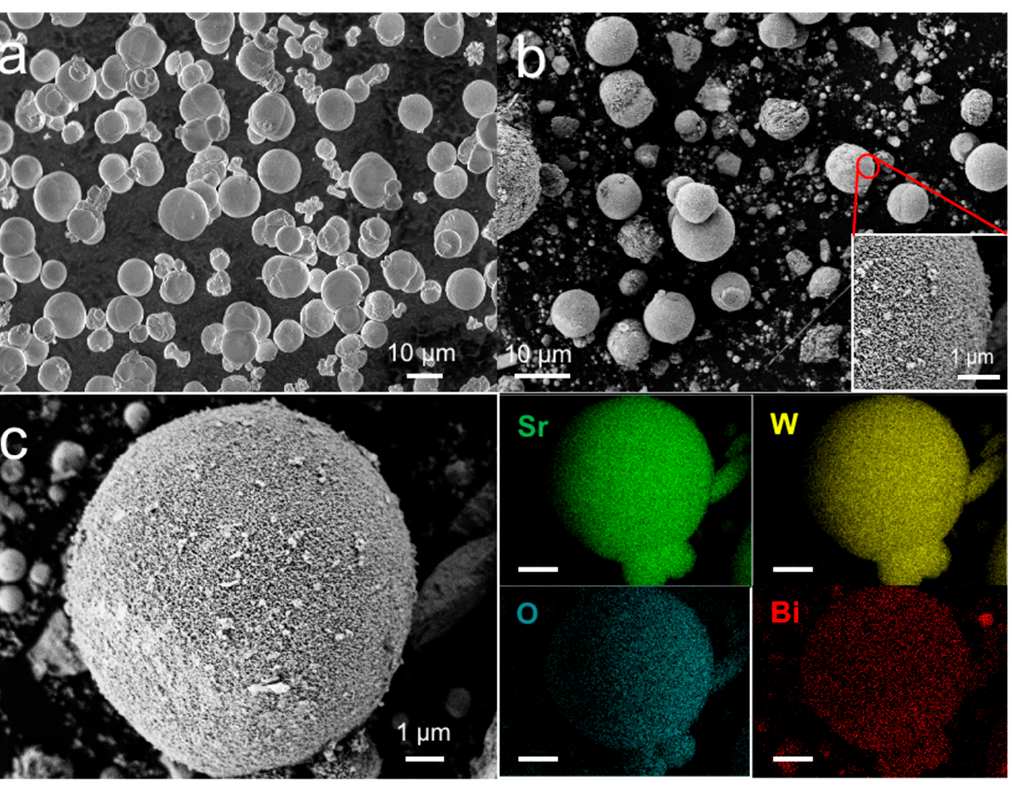
Figure 3 . SEM images of SWO ( a ) Bi/SWO-0.7 ( b ) and the elemental mapping analysis ( c ). The inset of panel ( b ) is the magnified image.